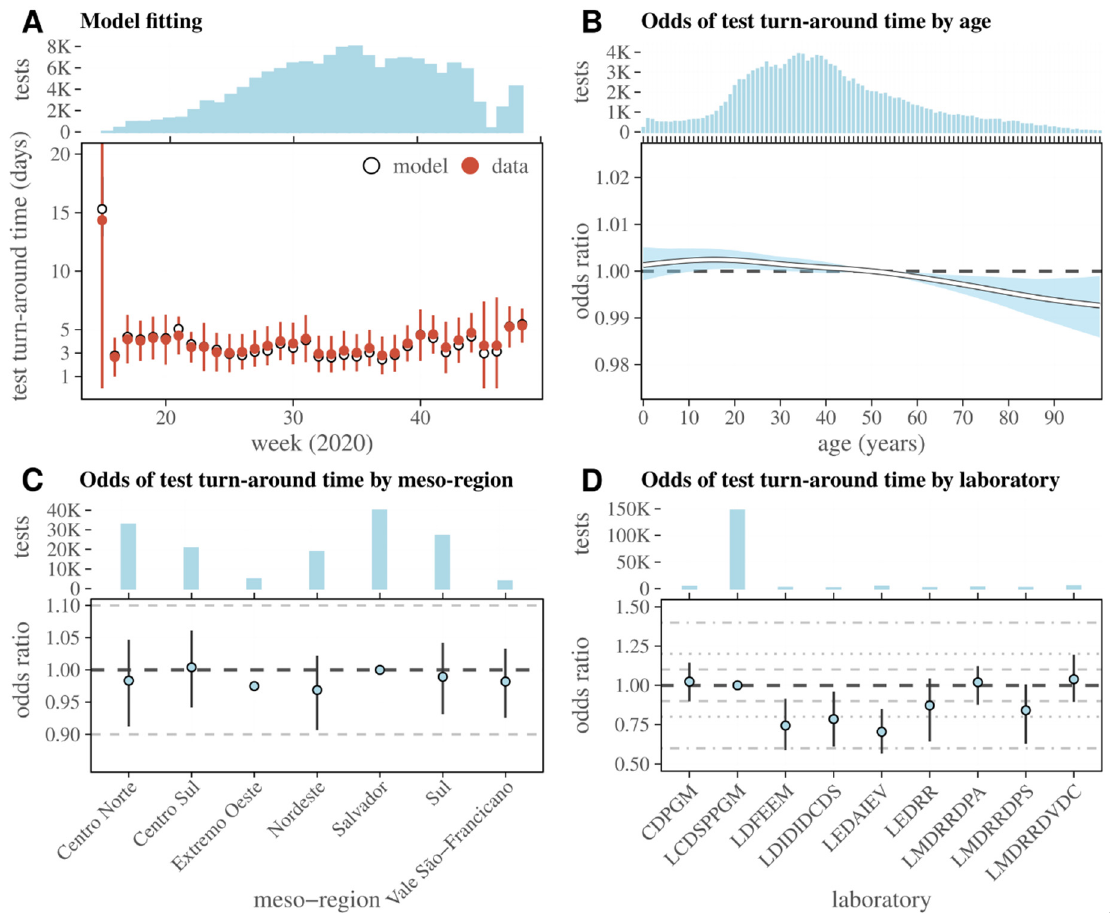
Figure 5. SARS-CoV-2 test turn-around time and odds ratio for time taken dependent on other variables (laboratory LCDSPPGM). ( A ) Model fit to test turn-around time (days between sample collection and test result) per week. Odds ratio of a positive test depending on ( B ) age, ( C ) meso-region of the tested individual, and ( D ) performing laboratory. ( A – D ) Top subpanels present the total tests (blue bars). The K in the y-axis refers to thousands. Whiskers are the 95% percentile and full circles the mean of the odds ratio. Values of reference (odds = 1) are the mode of each variable. The presented fit was extracted from the GAM model by setting the variable laboratory to LCDSPPGM; other laboratories are shown in Supplementary Figures S16–S18.